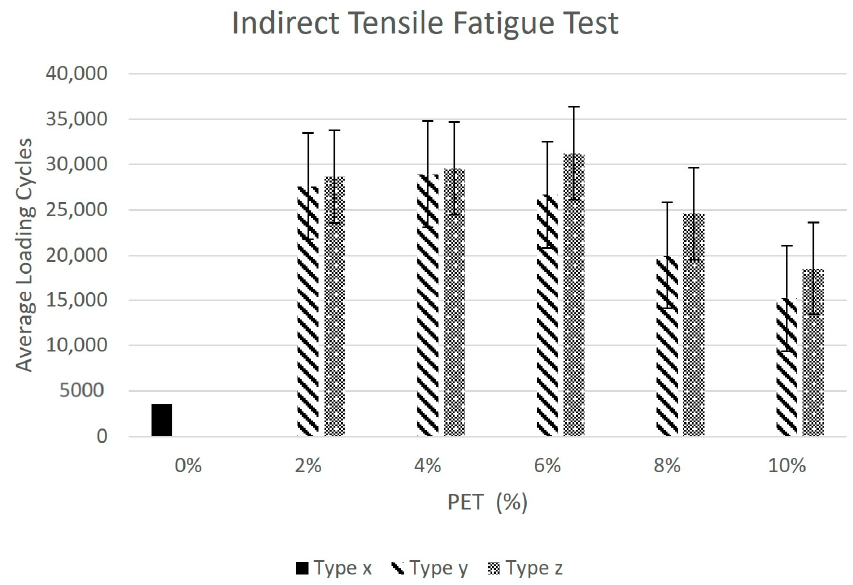
Figure 10. Indirect tensile fatigue test.